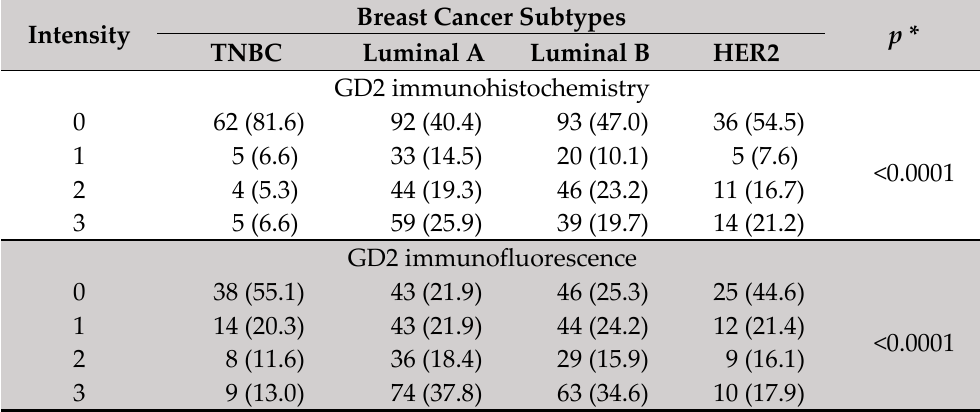
Table 2. Proportions of samples among the breast cancer subtypes that expressed GD2 at the individual intensities 1, 2, or 3 on immunohistochemistry or immunofluorescence.